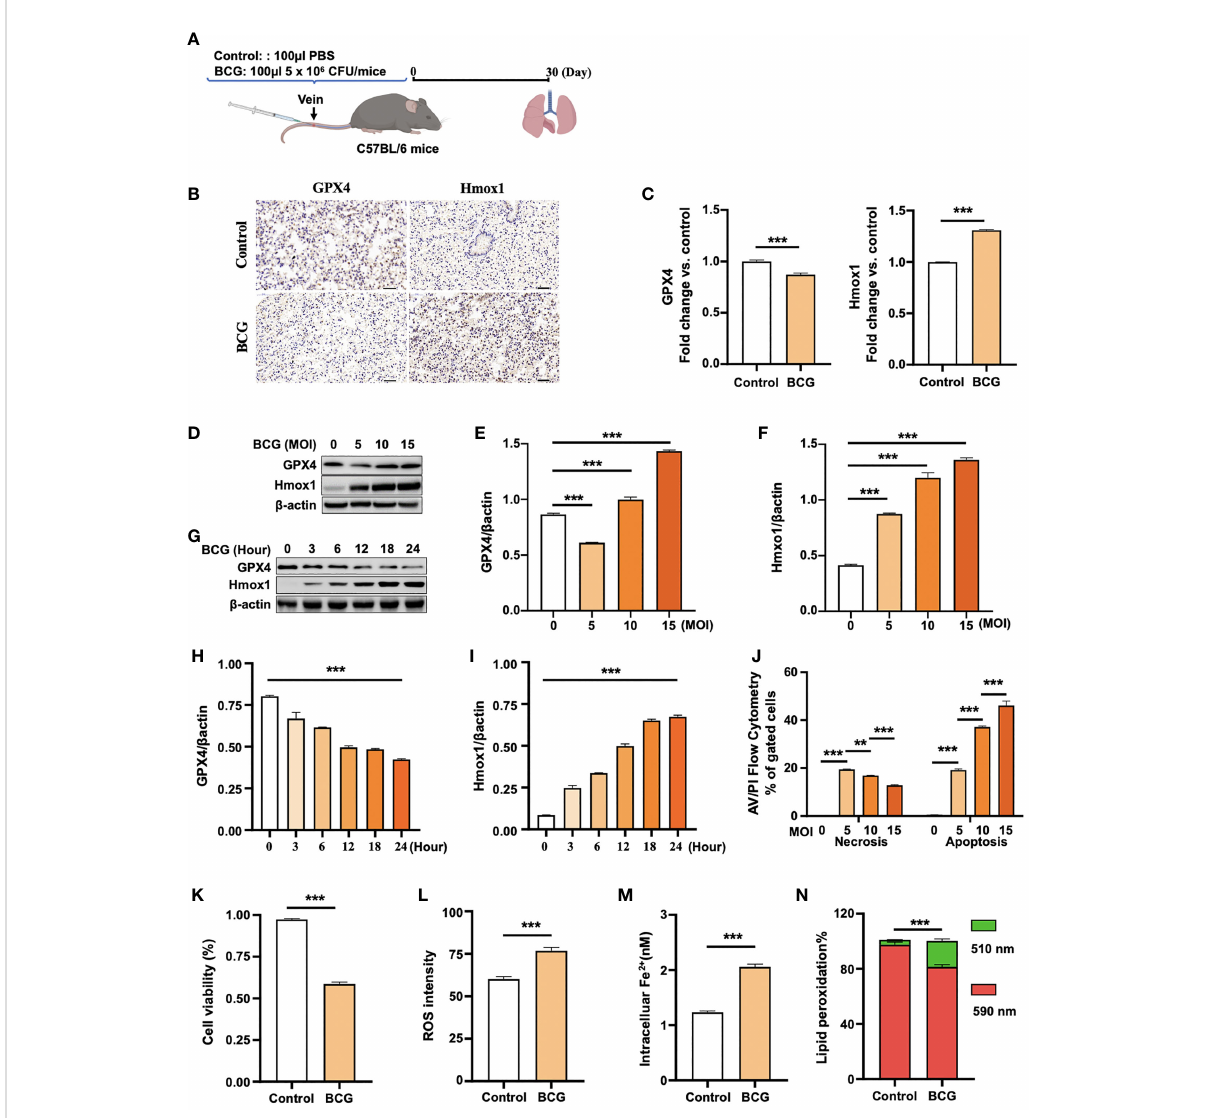
FIGURE 2 BCG induces ferroptosis in macrophages. (A) Schematic diagram shows the infection of mice with BCG via tail vein injection. The infected mice are analyzed at 30 days post-infection (DPI). (B, C) C57BL/6 mice were injected with 5 × 10 6 CFU BCG in 100 µl via the tail vein and the lungs were harvested for evaluating the expression of Gpx4 and HO-1 proteins at 30 DPI by immunohistochemical (IHC) assay (B) and semi-quanti fi ed by ImageJ-IHC Pro fi ler (C) . Lungs of mice infected with BCG showed less and more abundant Gpx4 and HO-1 proteins compared to the uninfected controls, respectively. Bar represents 500 m m in (B)(D-F) RAW264.7 murine macrophage-like cells were infected with BCG at indicated MOI for 24 h, and the abundance of Gpx4 and HO-1 proteins was examined by Western blotting assay. The representative blots (D) and semi-quanti fi cation of Gpx4 (E) and HO-1 (F) showed a dose-dependent induction of Gpx4 and HO-1 in this type of cells, except an inhibition of Gpx4 expression in cells infected with a low dose of BCG at an MOI of 5. (G – I) The representative blots (D) and semi-quanti fi cation of Gpx4 (H) and HO-1 (I) demonstrated a time-dependent inhibition of Gpx4 and induction of HO-1 in RAW264.7 infected with BCG at an MOI of 5 for a 24-h time period. (J) Induction of cell necrosis and apoptosis in RAW264.7 cells at 24 h post-infection of BCG at the indicated MOI determined by using Annexin V/PI in fl ow cytometry. (K) Cell viability assay showed that the infection of BCG decreased the viability of RAW264.7 cells at an MOI of 5 for 24 has detected by Trypan Blue assay. (L) The infection of BCG induced the production of intracellular ROS in RAW264.7 cells at an MOI of 5 for 24 has detected by fl ow cytometry assay. (M) The infection of BCG increased the concentration of intracellular Fe 2+ in RAW264.7 cells at an MOI of 5 for 24 has detected using iron ion probes. (N) The infection of BCG induced lipid peroxidation in RAW264.7 cells at an MOI of 5 for 24 h as determined by BODIPY 581/591 C11 assays. Upon oxidation, its excitation of Red/590 nm shifts to 510 nm (Green). The ratio of Green/Red cells in the BCG-infected cells was 17.22%, while the uninfected cells was 3.52%. Data obtained from three independent experiments were processed using GraphPad Prism 8.0.1 software and ImageJ 1.52.a. Unpaired t -test was used to analyze the differential changes of the two groups. One-way ANOVA and Tukey ’ s multiple comparisons test was used to analyze the differential changes of multiple groups. Data represented mean ± SD from three independent experiments; signi fi cant differences are indicated with asterisks (** p < 0.01; *** p <